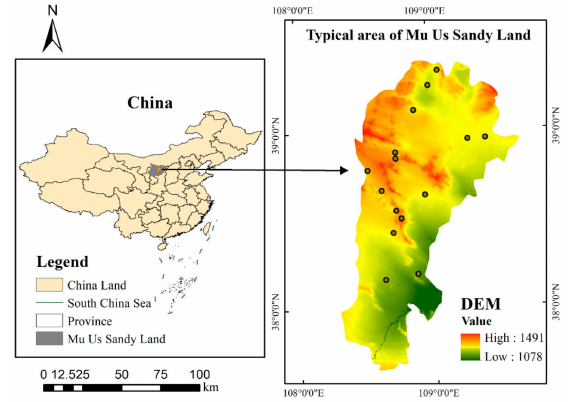
Figure 1. Location of the study